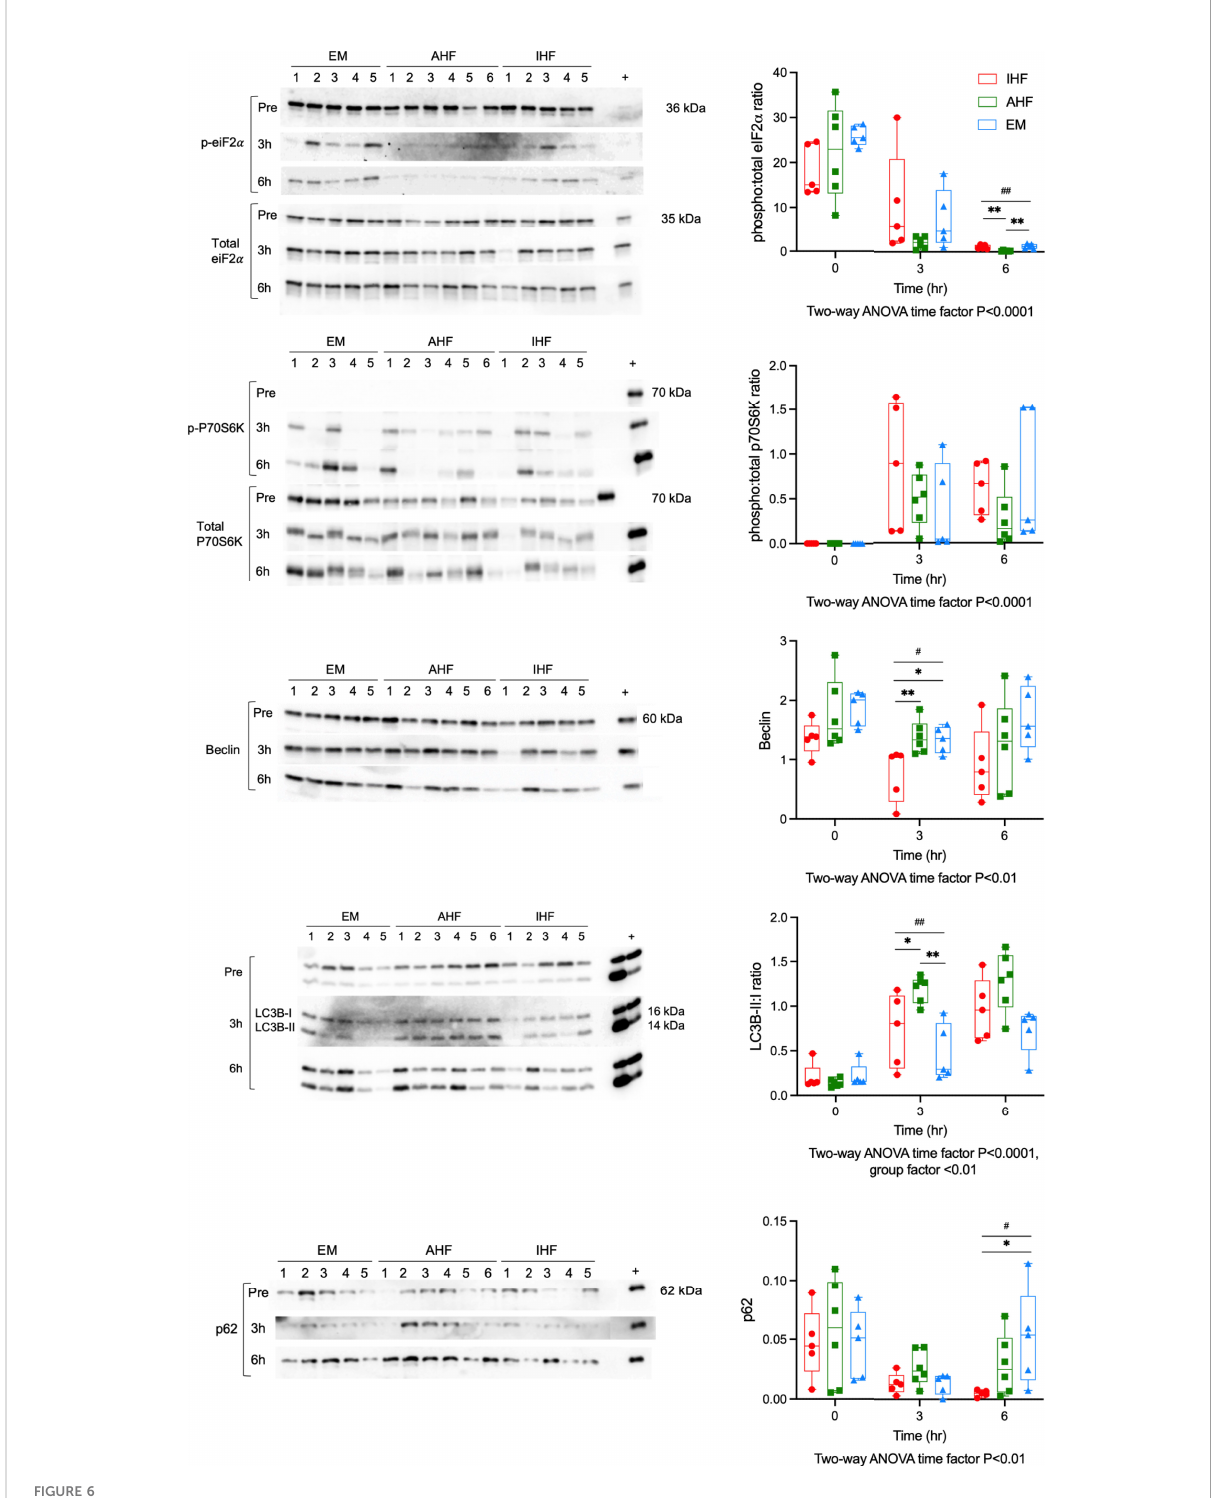
FIGURE 6 Autophagy and the unfolded protein response during liver NMP. Western immunoblots of (A) phosphorylated to total protein ratio of eiF2 a , (B) phosphorylated to total protein ratio P70S6K, (C) Beclin, (D) LC3B-II to LC3B-I ratio, and (E) p62. Kruskal-Wallis test: ## P<0.01, # P<0.05; Wilcoxon ranksum test: ** P<0.01, * P<0.05. NMP, Normothermic machine perfusion; AHF, adequate hepatocellular function; IHF, inadequate hepatocellular function; EM, emricasan; eiF2 a , eukaryotic initiation factor 2 a ; P70S6K, P70 S6 kinase; LC3B, microtubule-associated protein 1 light chain 3